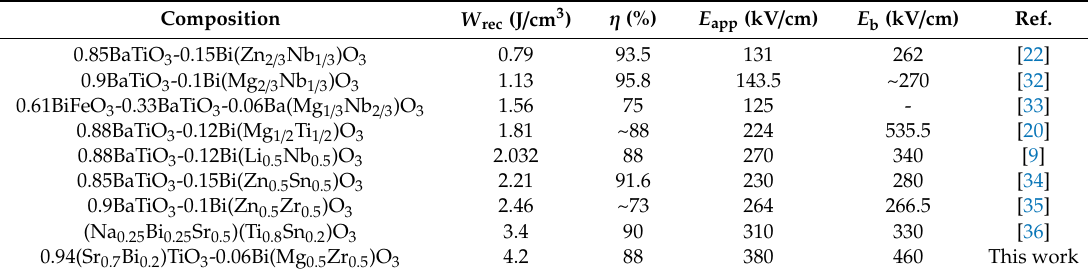
Table 2. Comparison of energy-storage properties between the 0.94SBT-0.06BMZ ceramic and other lead-free